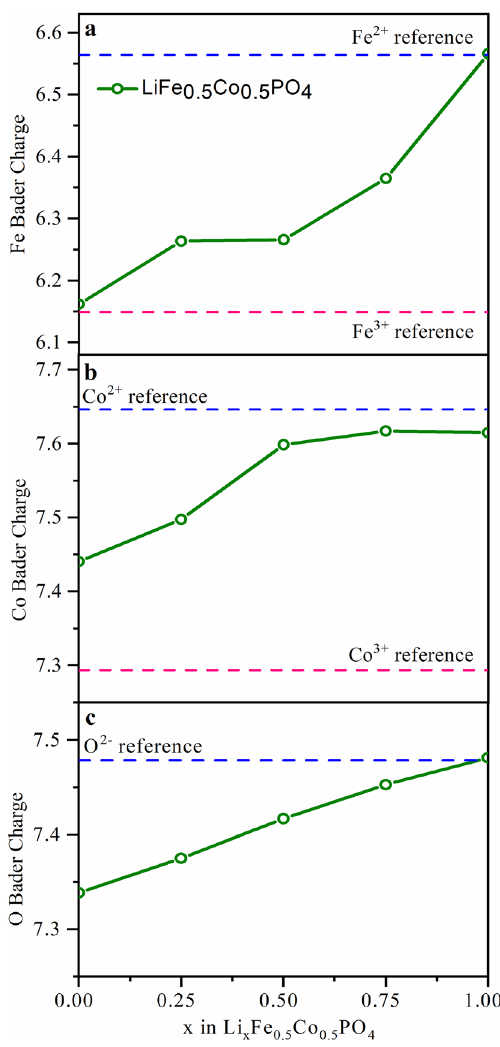
Figure 7. Unit cell averaged local atomic (Bader) charges for Fe ( a ), Co ( b ) and O ( c ) as a function of x in Li x Co 0.5 Fe 0.5 PO 4 (x = 0, 0.25, 0.5, 0.75, and 1). The values for each species were averaged over non-equivalent atomic positions. Reference charge values (dashed lines) were obtained from calculations for reference compounds with different Co and Fe oxidation